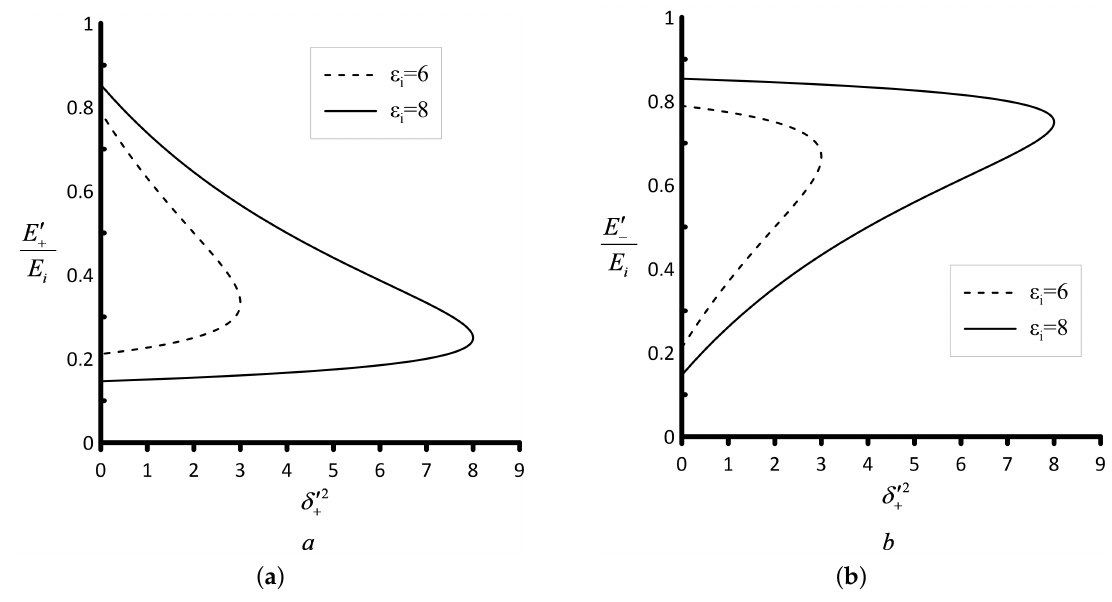
Figure 2. Final positron ( a ) and electron ( b ) energy as a function of δ (cid:48) + 2 for two values of ε i